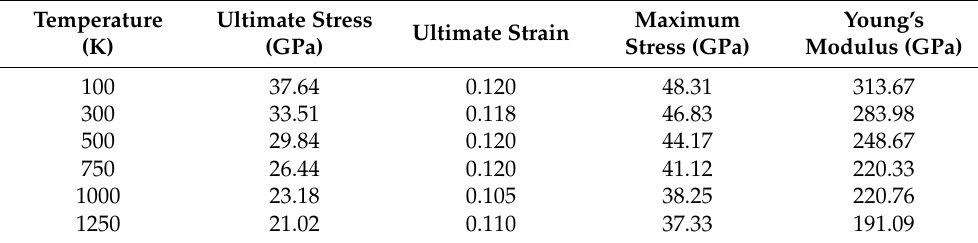
Table 1. Uniaxial tensile results of PGO under different temperatures.